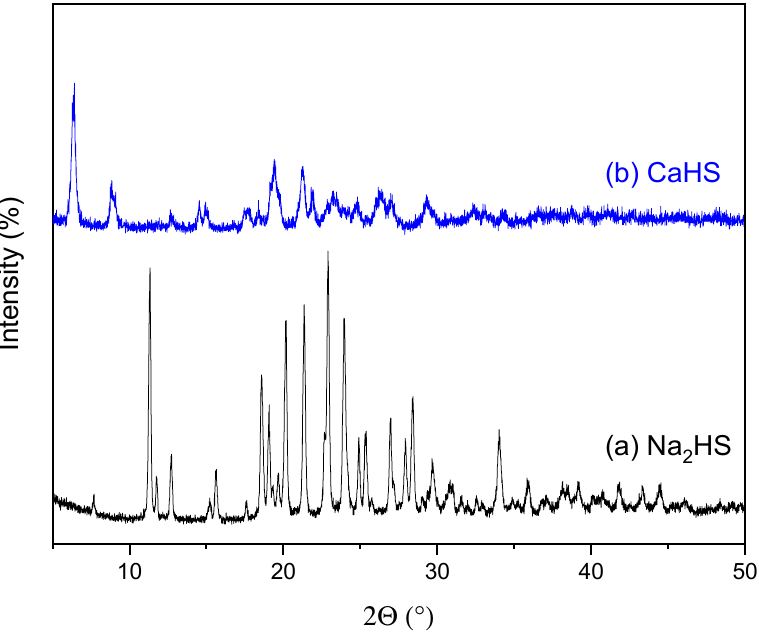
Figure 1. XRD spectra of (a) Na 2 HS and (b) CaHS.